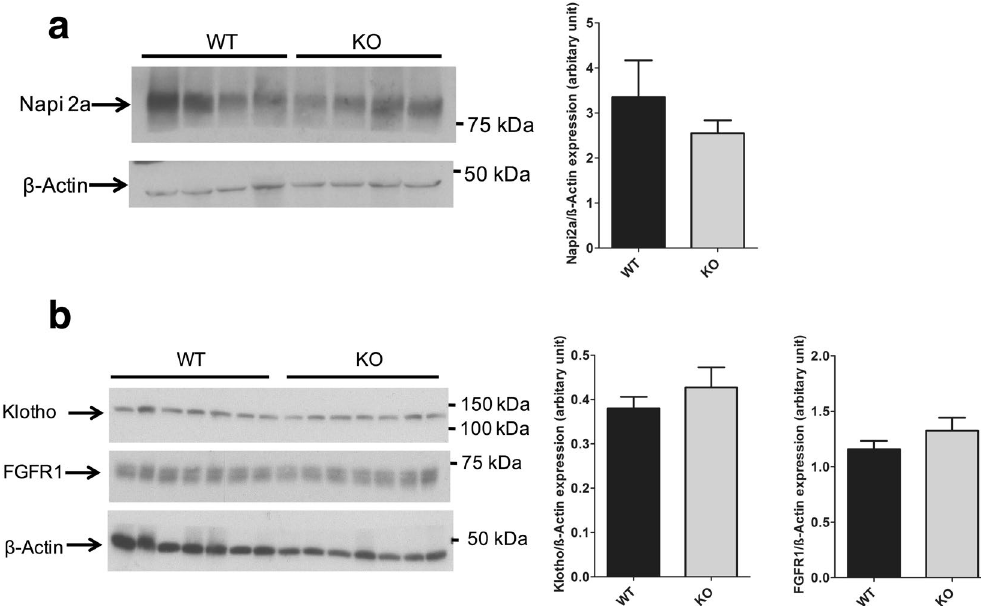
Figure 4. Brush border abundance of Napi2a and renal expression of α -Klotho and FGFR1. ( a ) Original western blot of Napi2a and beta actin in BBM isolated from NCC WT and KO kidneys. Quantification of Napi2a expression in WT and KO kidneys. ( b ) Original western blot of α -Klotho, FGFR1 and beta actin in total kidney lysate from NCC WT and KO kidneys. Quantification of α -Klotho and FGFR1 expression in WT and KO kidneys.